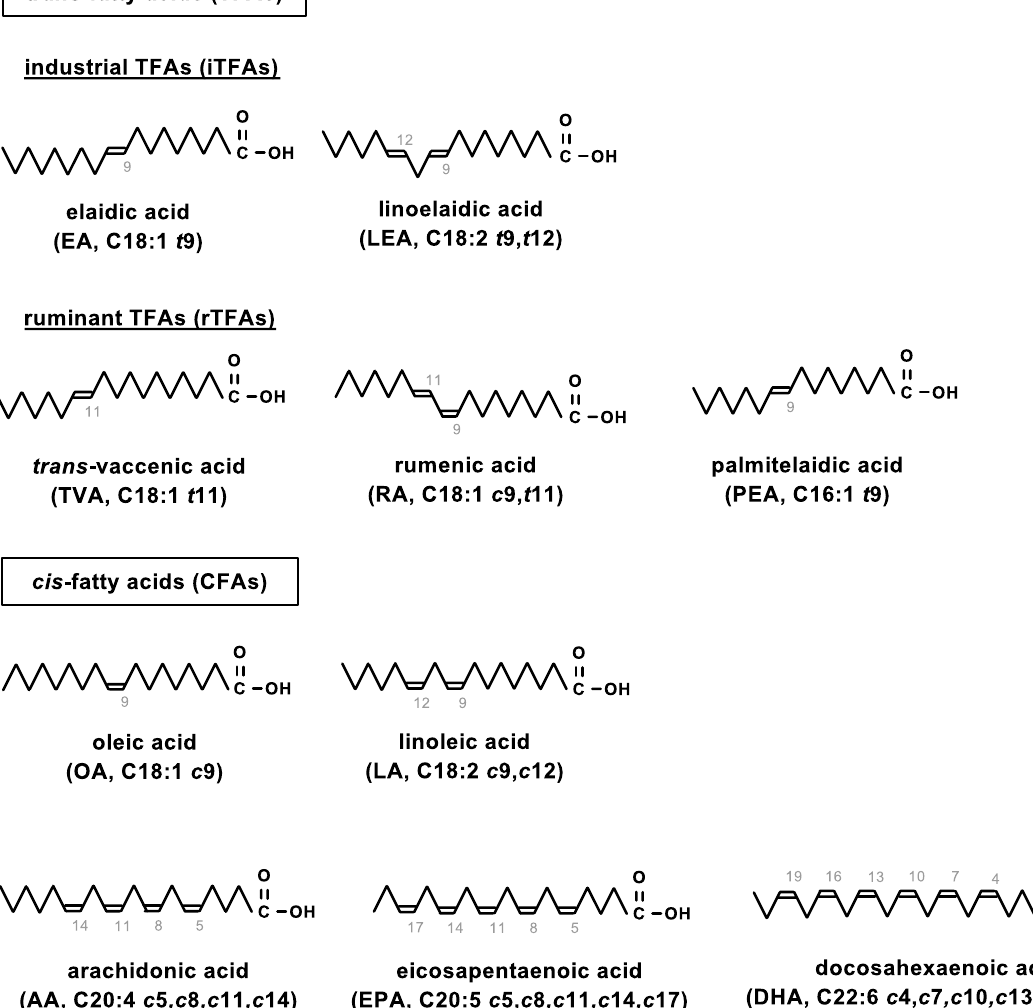
Figure 1. Structures of the fatty acids utilized in this study. The numbers in the figure represent the positions of carbon–carbon double bonds. In parentheses, the following information is shown: abbreviation, the number of carbon atoms, and the number, configuration ( t , trans ; c , cis ) and positions of the carbon–carbon double